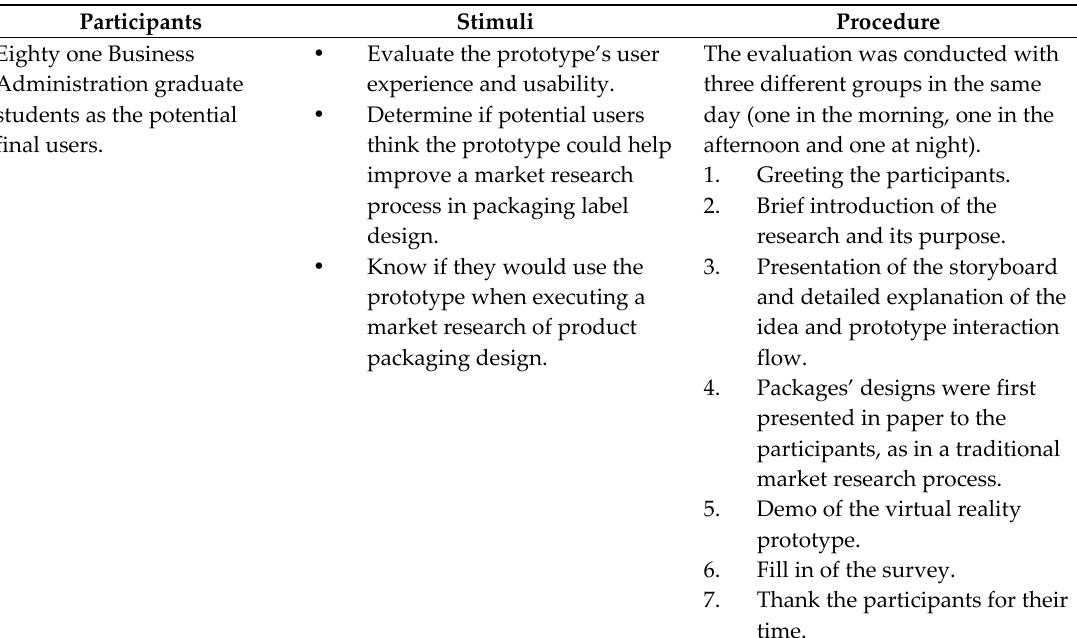
Table 2. Prototype evaluation